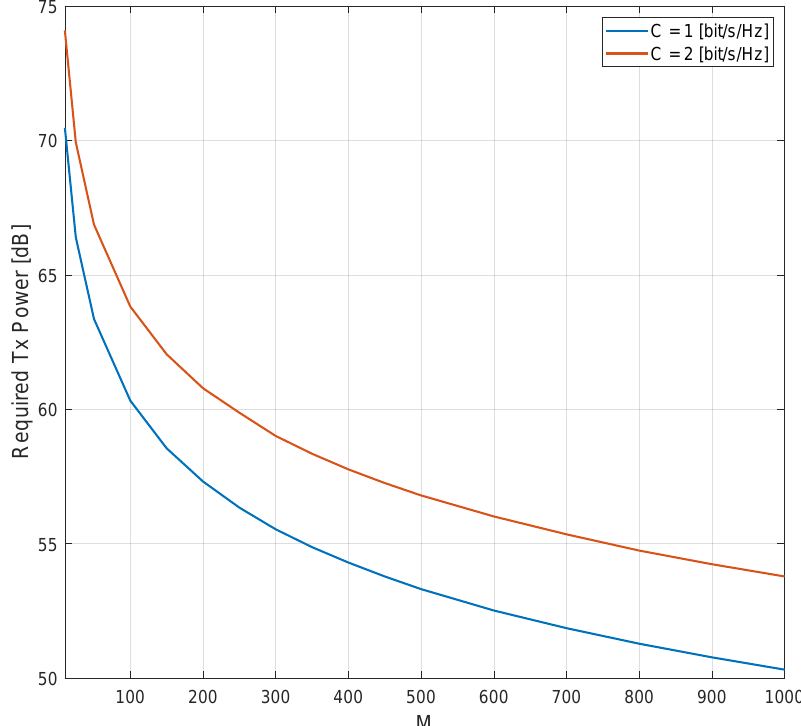
Figure 6. Required transmit power to achieve 1 and 2 bits/s/Hz as a function of the number of